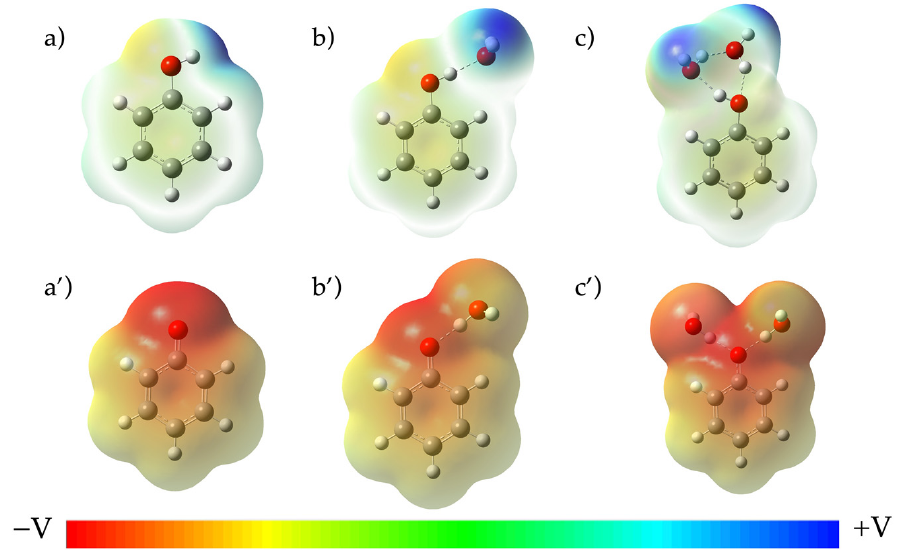
Figure 3. Isosurface of electrostatic potential plotted at a value of 0.0004 of phenol (top) and phenate (bottom) with: 0 ( a , a’ ), 1 ( b , b’ ), 2 ( c , c’ ) explicit water molecules. Calculations were performed with CAM-B3LYP/6-311G+dp/SMD level of theory.